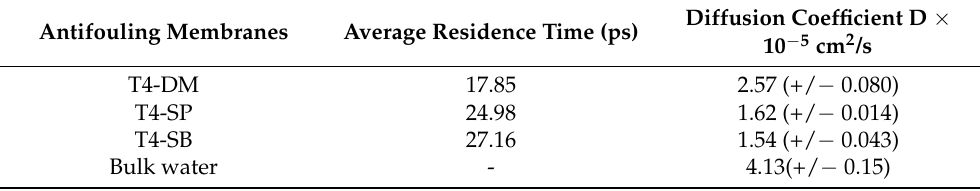
Table 2. Dynamic properties of hydration layer water molecules above three antifouling membranes including average residence time and diffusion